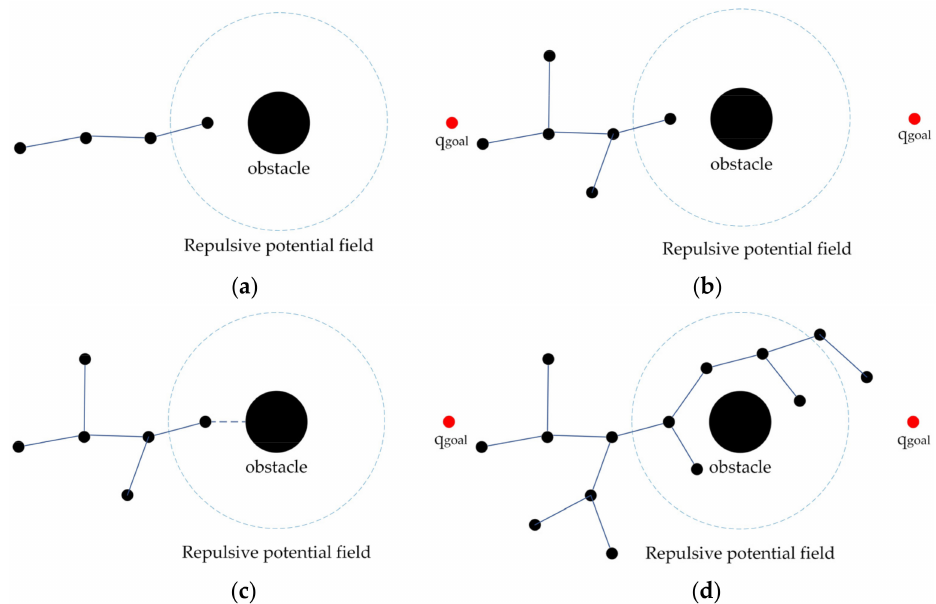
Figure 3. The random tree falls into a trap in the repulsive potential field. ( a ) The random tree entering obstacle potential field; ( b ) The random tree begins to expand randomly; ( c ) The random trees collide with obstacles; ( d ) The random tree is expanded several